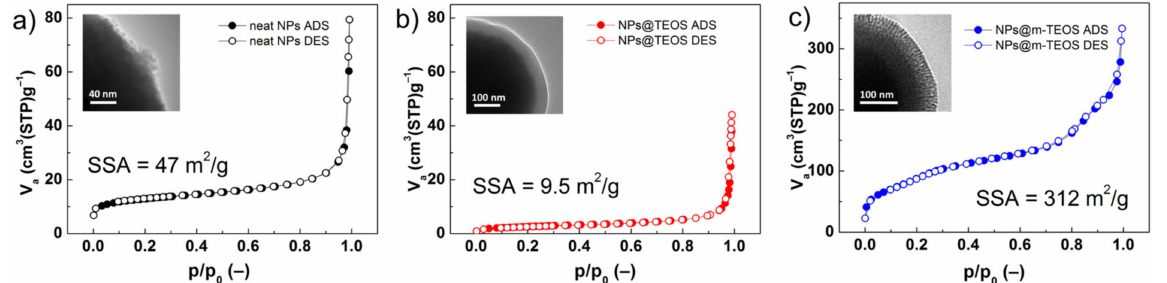
Figure 4. Nitrogen adsorption/desorption ( solid/open symbols ) isotherms for the ( a ) neat NPs, ( b ) NPs@TEOS and ( c ) NPs@m-TEOS; the insets highlight differences in surface topology.